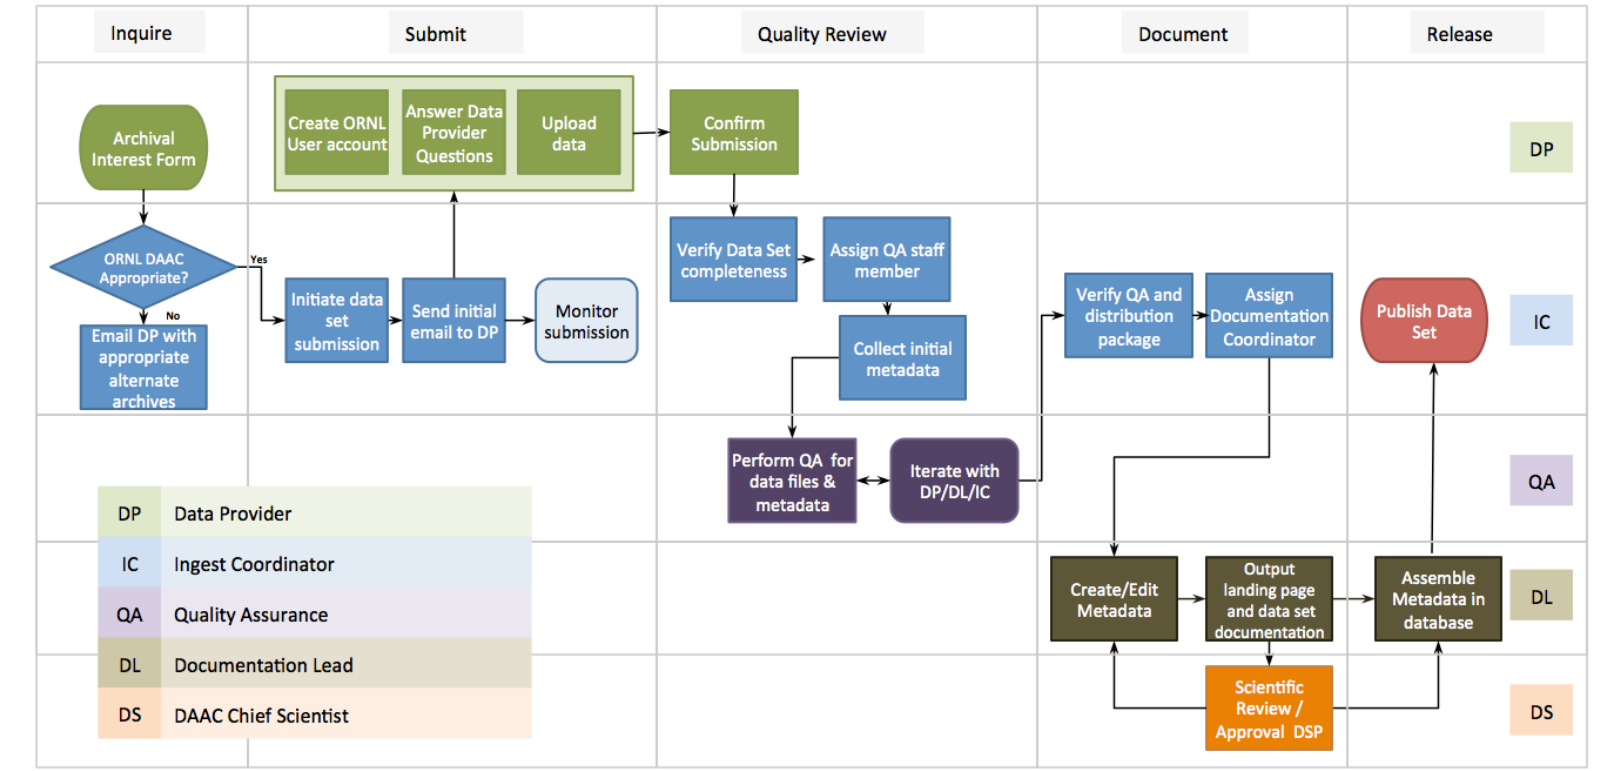
Figure 6. Detailed View of the SAuS workflow with various ingest roles defined (Inquire, Submit, Quality, Document, and Release). 2